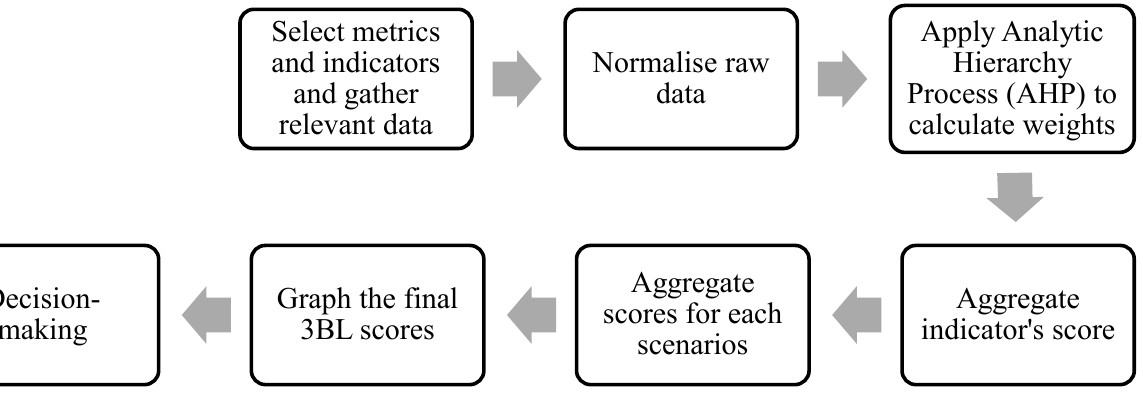
Figure 2. The steps that were used to assess technologies for EMP.